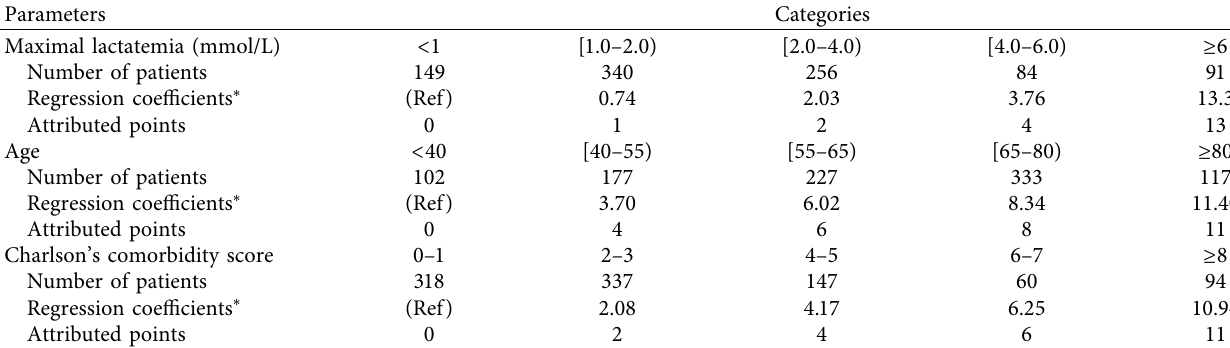
Table 3: The metabolic failure, age, and comorbidity assessment (MACA) score.